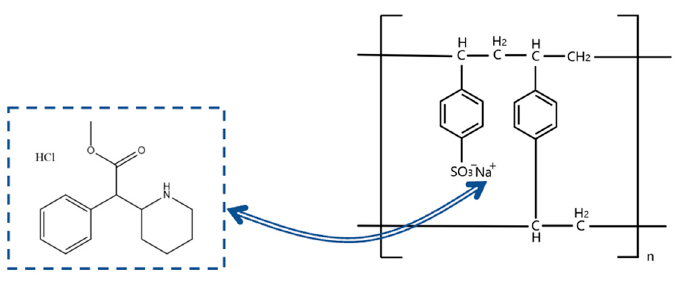
Figure 1. Schematic diagram of the ion-exchange reaction between methylphenidate hydrochloride (MPH) and Amberlite ® IRP69.